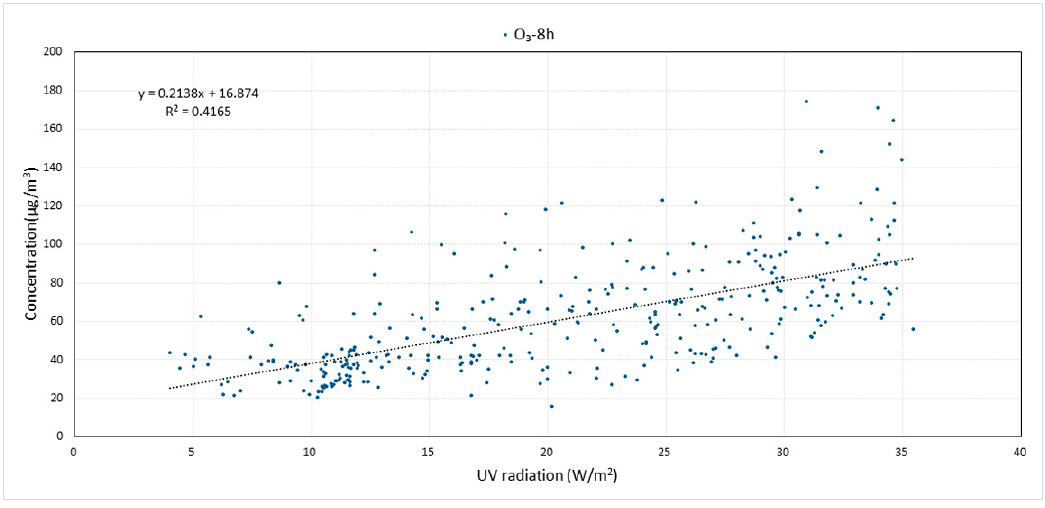
Figure 8. Correlation between O 3 and solar radiation ( n = 1095).